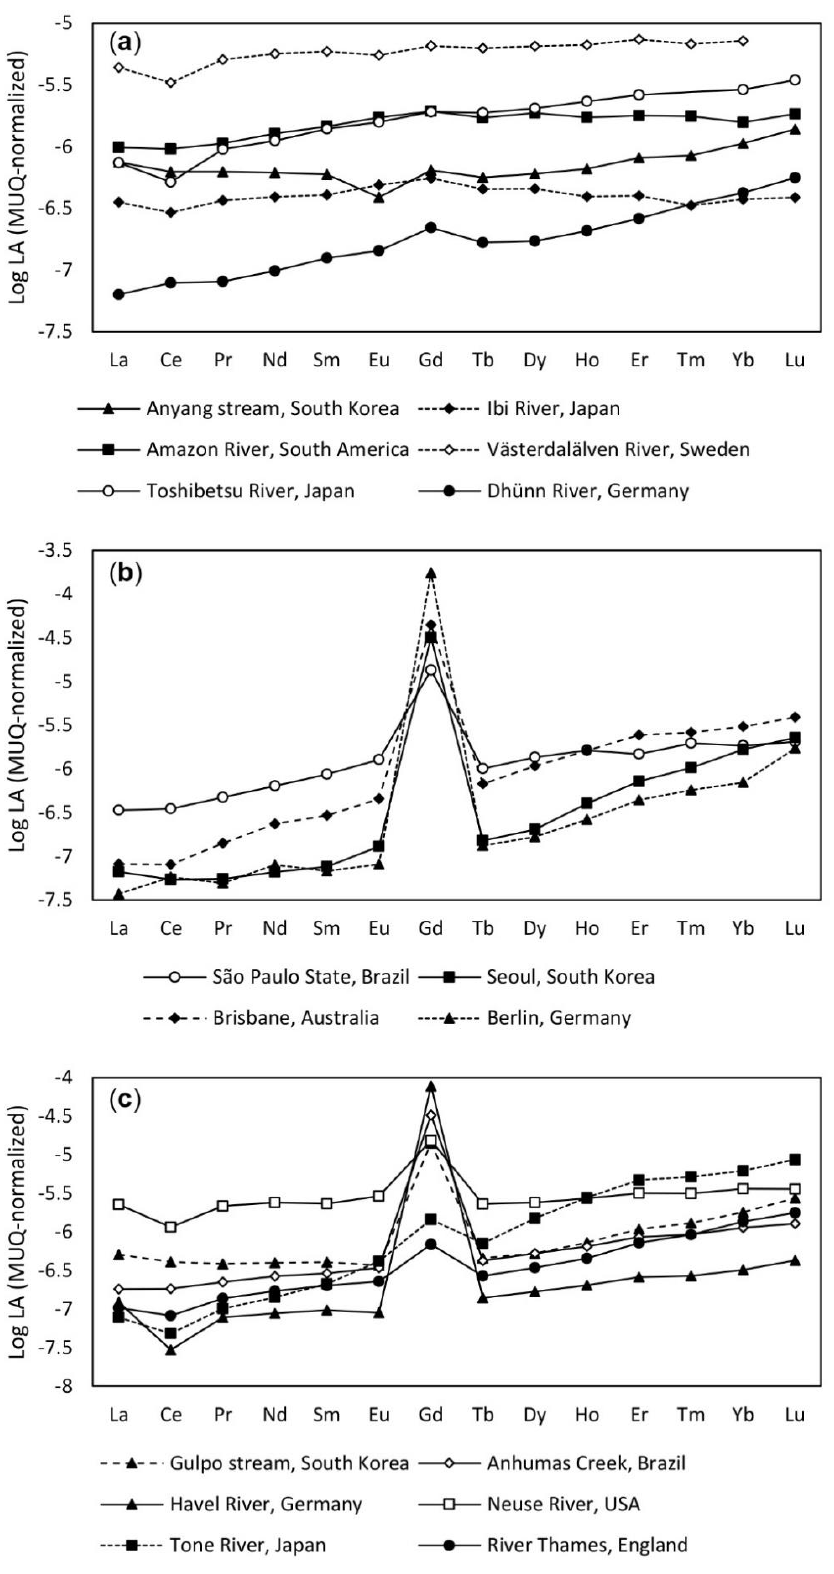
Figure 2. MUQ-normalized LA patterns of: ( a ) River waters without Gd anth ; ( b ) WWTP effluents with pronounced positive Gd anomaly; ( c ) river waters with Gd anth . The data are from Bau and Dulski, [7], Nozaki et al. [11], Gaillardet et al. [78], Zhu et al. [12], Lawrence et al. [16], Kulaksız and Bau [10], de Campos and Enzweiler [17], Song et al. [13], and Smith and Liu [19].